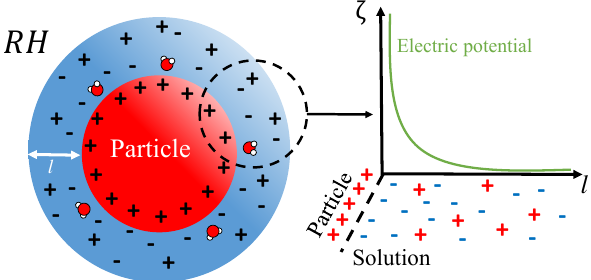
Figure 2. Schematic of the system considered herein – an idealized solvating atmospheric particle. The use of an idealized spherical ge- ometry is justified by previous findings that NaCl crystal corner and step sites dissolve preferentially to surface sites, in a manner that quickly roughens and rounds faceted crystals (Chen et al.,